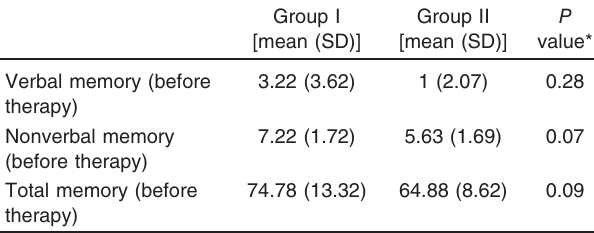
Table 3 Working memory results comparing the working memory group and the control group (before